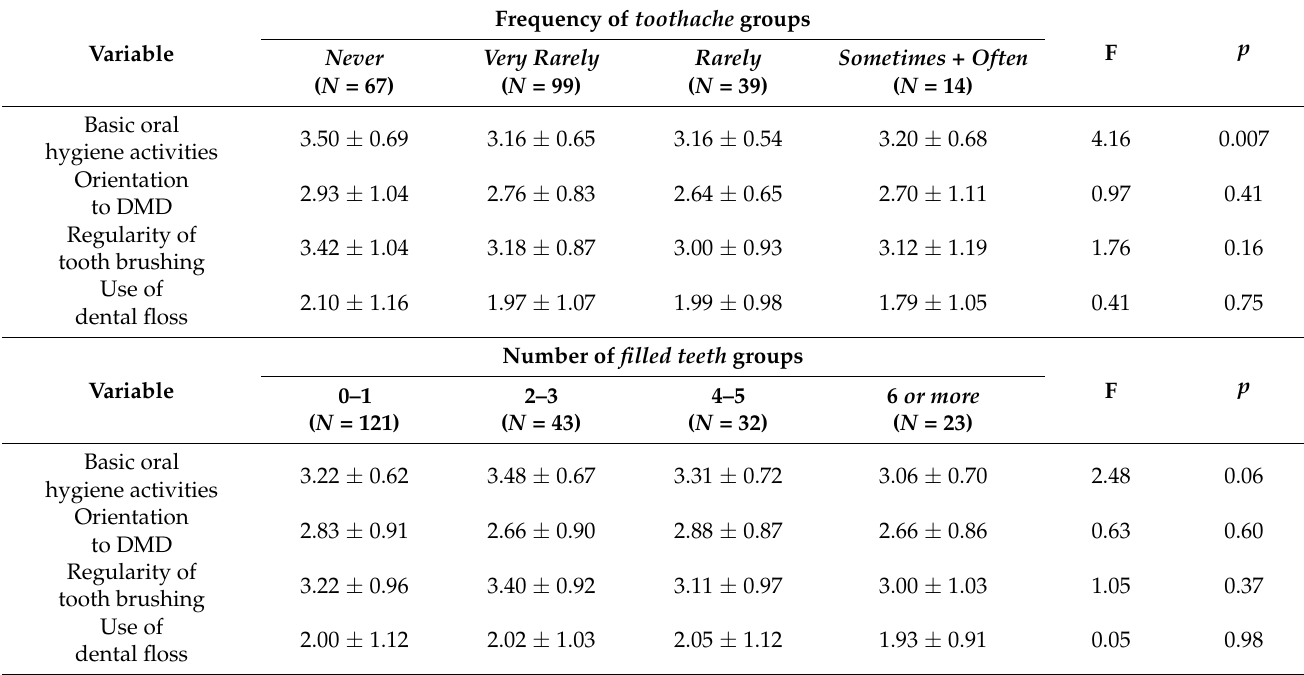
Table 9. Analysis of variance of the OH status groups for male